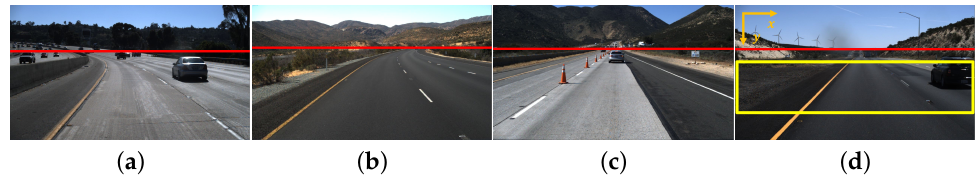
Figure 2. Red lines indicate the vanishing lines of lane markings: ( a ) leftward curve; ( b ) rightward curve; ( c ) downhill; and ( d ) uphill. The yellow rectangle is a regular ROI of the proposed